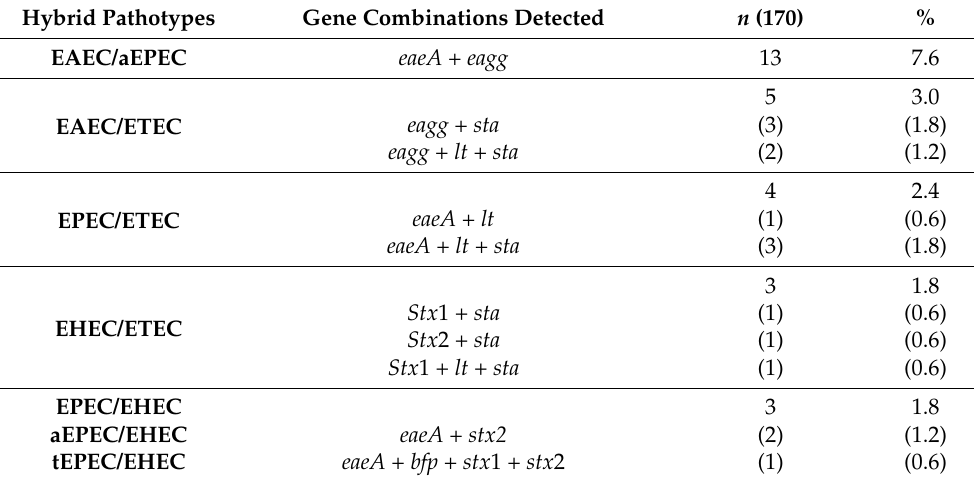
Table 3. Escherichia coli hybrid pathogenic types (two pathotypes) and their virulence genes detected in this study.